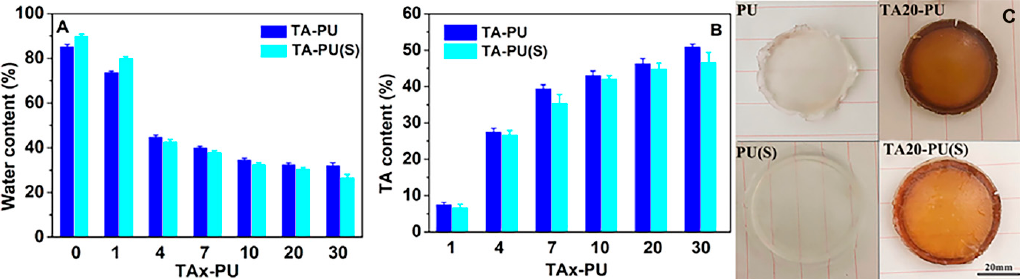
Figure 2. Water content ( A ) and tannic acid (TA) content ( B ) of TAx–PU hydrogels; photos of PU and TAx–PU gels before and after swelling in distilled water ( C ).